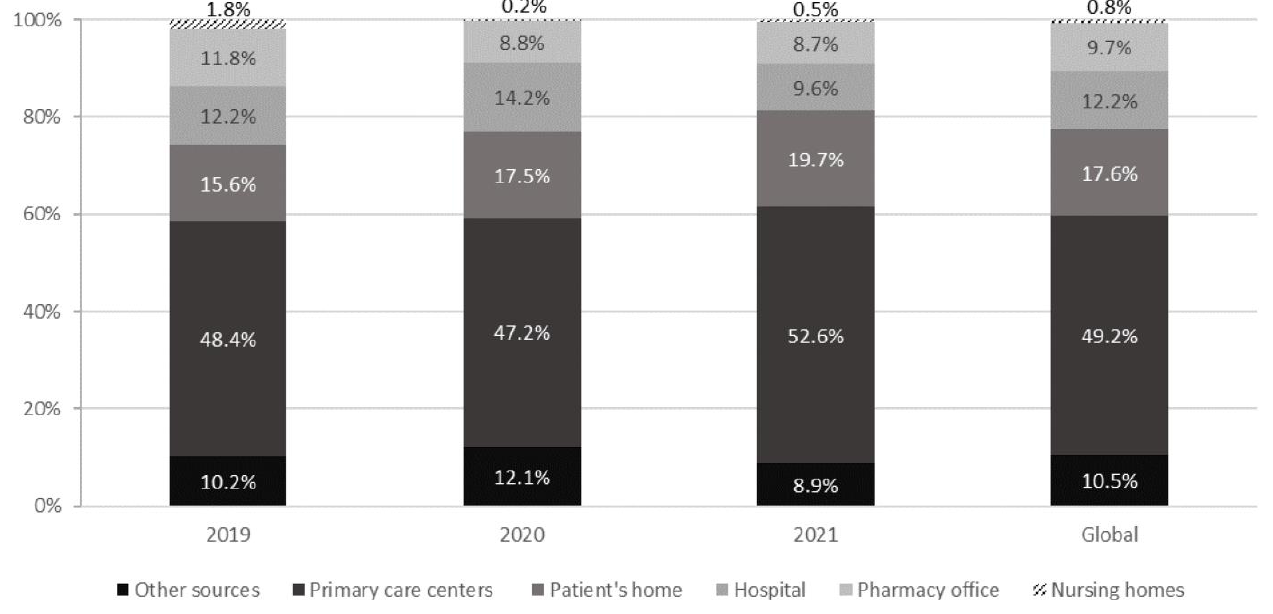
Figure 2. Percentages of reported MEs based on the places where the MEs occurred (Catalonia, 2019–2021). Table 1. Numbers and percentages of ME cases based on the causes and processes of the therapeutic chain involved in the ME (Catalonia,